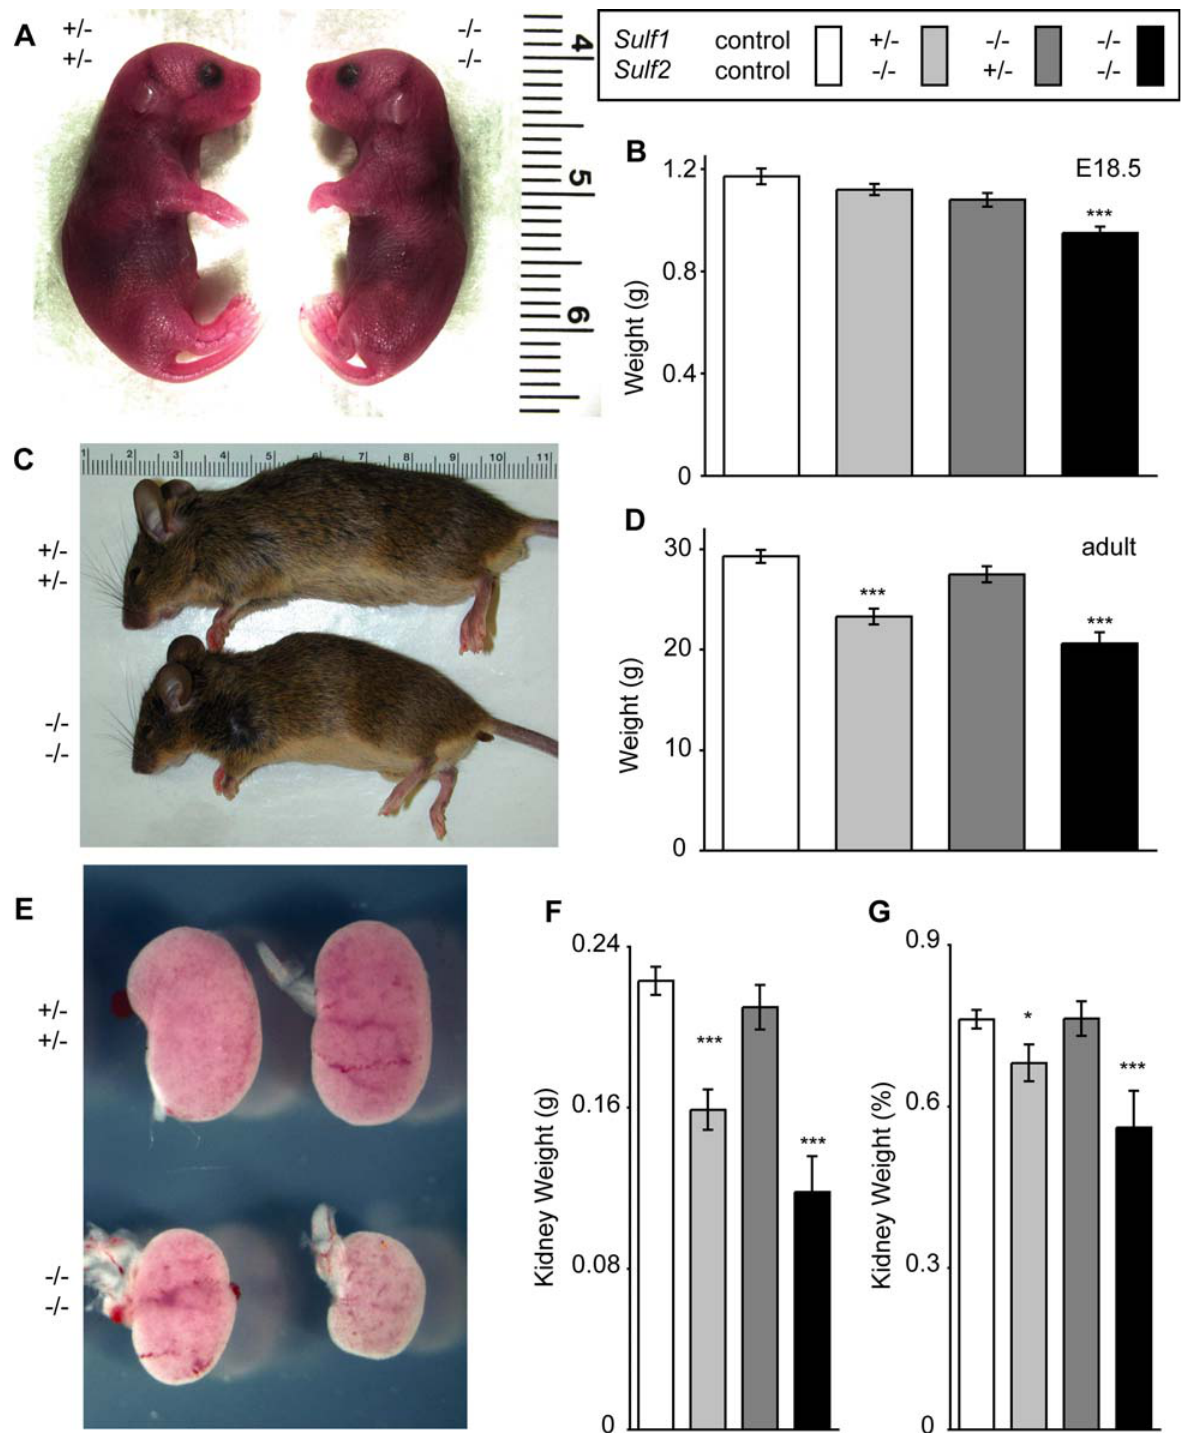
Figure 2.Sulf1 -/- Sulf2 -/- mice have decreased body and kidney weights at birth and (for the few that survive) as adults. (A) Representative image of Sulf1 -/- Sulf2 -/- and littermate control E18.5 day embryos just after birth, but prior to feeding. Note the pink skin-tone and apparently normal vascularization and circulation. (B) Quantification of embryo weight (mean 6 SEM) at E18.5. Sulf1 -/- Sulf2 -/- embryos show a 19% decrease in weight. These embryos also have a 12% decreased crown-rump length (data not shown). Number of embryos analyzed were as follows: Control (pooled + / + ; + / + , + /- ; + / + , + / + ; + /- , and + /- ; + /- embryos), n =31; Sulf1 + /- Sulf2 -/- , n =32; Sulf1 -/- Sulf2 + /- , n =26, and Sulf1 -/- Sulf2 -/- , n =24. (C) Representative image of a typical small Sulf1 -/- Sulf2 -/- 10-week-old male and a control littermate. Note the proportionate small stature and the lack of gross morphological differences. (D) Body weights (mean 6 SEM)of15-week-old males. Weights of Sulf2 -/- and Sulf1 -/- Sulf2 -/- mice were , 20% and , 30% smaller,respectively, thancontrols. Number ofadult males analyzed were as follows: Controls ( Sulf1 + /- Sulf2 + /- ), n =26; Sulf1 + /- Sulf2 -/- , n =8; Sulf1 -/- Sulf2 + /- , n =10, and Sulf1 -/- Sulf2 -/- , n =5. (E, F, G) Kidneys of Sulf1 -/- Sulf2 -/- mice weresmall at E18.5 (E) and remain disproportionately small (mean 6 SEM)into adulthood (F, G). The Sulf2 -/- mutants also had kidneys of decreased size, though the degree of reduction was more proportional to these animals’ decrease in body weight. The weights of 15-week-old adult male kidneys are represented as a percentage of total body weight in panel G. The kidneys analyzed here are from the same cohort of animals whose body weights were presented in panel D. Statistical significance was evaluated using a two-tailed Student’s t -test; *, p , 0.05. ***, p , 0.001. doi:10.1371/journal.pone.0000575.g002 PLoS ONE |